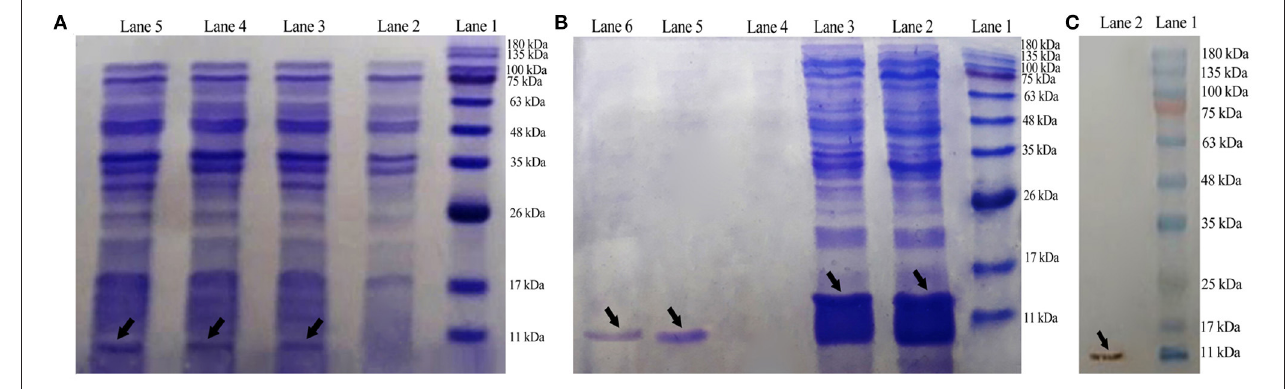
FIGURE 4 | Expression, Western blot analysis, purification, and characterization of recombinant MCh-AMP1. (A) SDS-PAGE showing the expression of pET28a( + )-DiMCh-AMP1: Lane 1, molecular weight marker (MWM); Lane 2, cells without IPTG induction; Lane 3, cells with IPTG induction after 1h; Lane 4, cells with IPTG induction after 2h; Lane 5, cells with IPTG induction after 4h. (B) Purification of the recombinant DiMCh-AMP1 peptide with 6X-His-tagged from pET28a: Lane 1, protein weight marker; Lane 2, flow through; Lane 3, washing column with wash buffer; Lanes 5 and 6, purified protein after elution with elution buffer. (C) Western